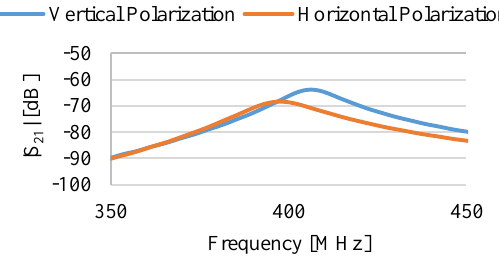
Figure 9. Transmission coefficient S 21 of ingestible and on- body antenna inside the anatomical